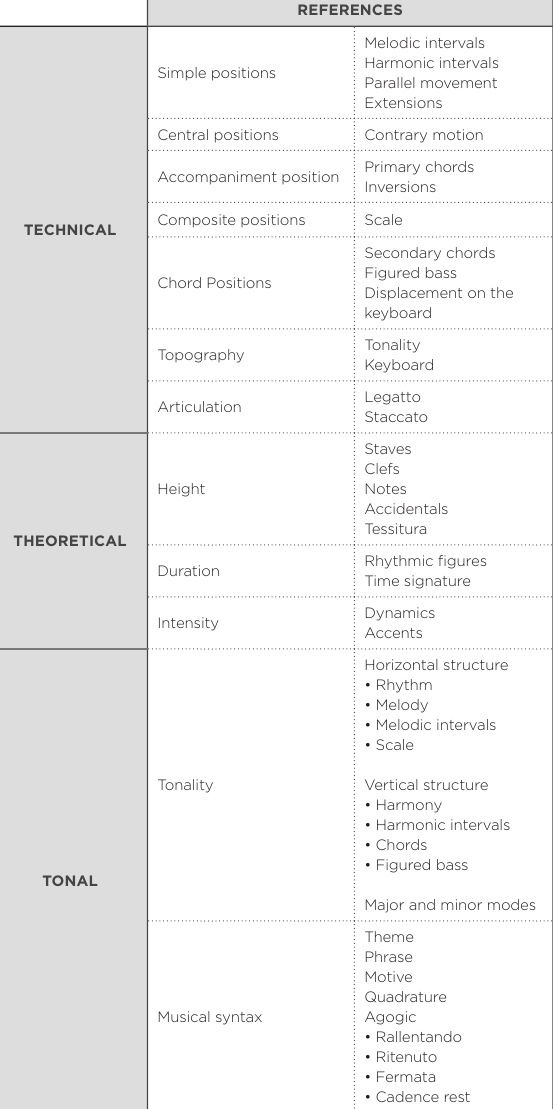
FIGURE 1 | C Position.